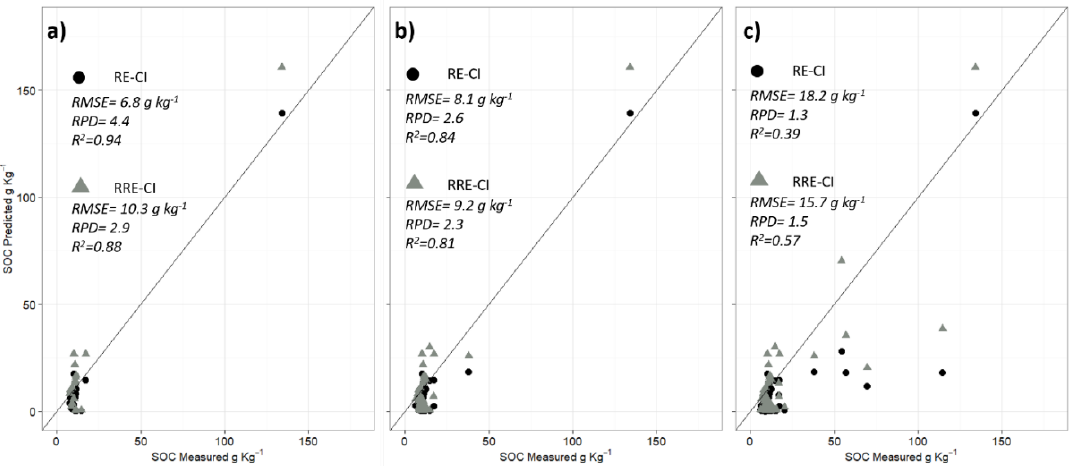
Figure 10. Plots of measured vs. predicted soil organic carbon values for the Red-Edge Carbon Index (RE-CI) and Red-Red-Edge Carbon Index (RRE-CI) index using an Normalized Burn Ratio 2 (NBR2) threshold of 0.05 ( a ), 0.075, ( b ) and 0.1 ( c ).